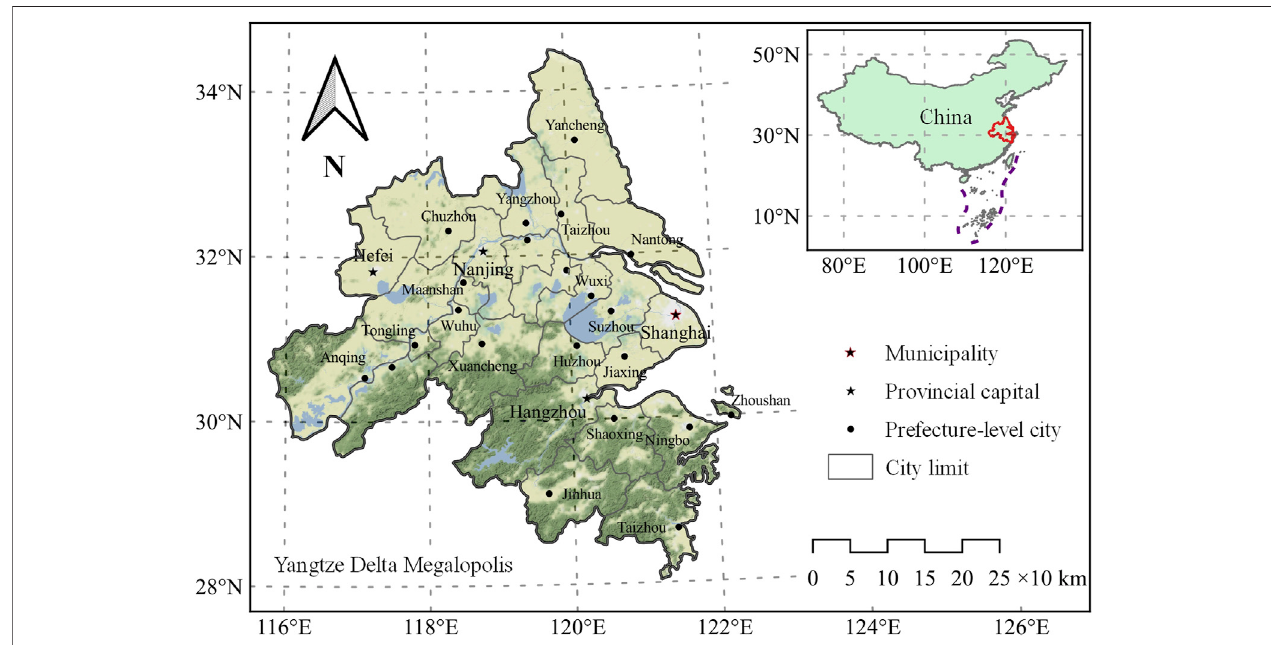
FIGURE1| ThestudyareaoftheYangtzeDeltaMegalopolis,China.TerraintilesbyStamenDesign(TerrainClassicContributors,2021)areusedasabackground.